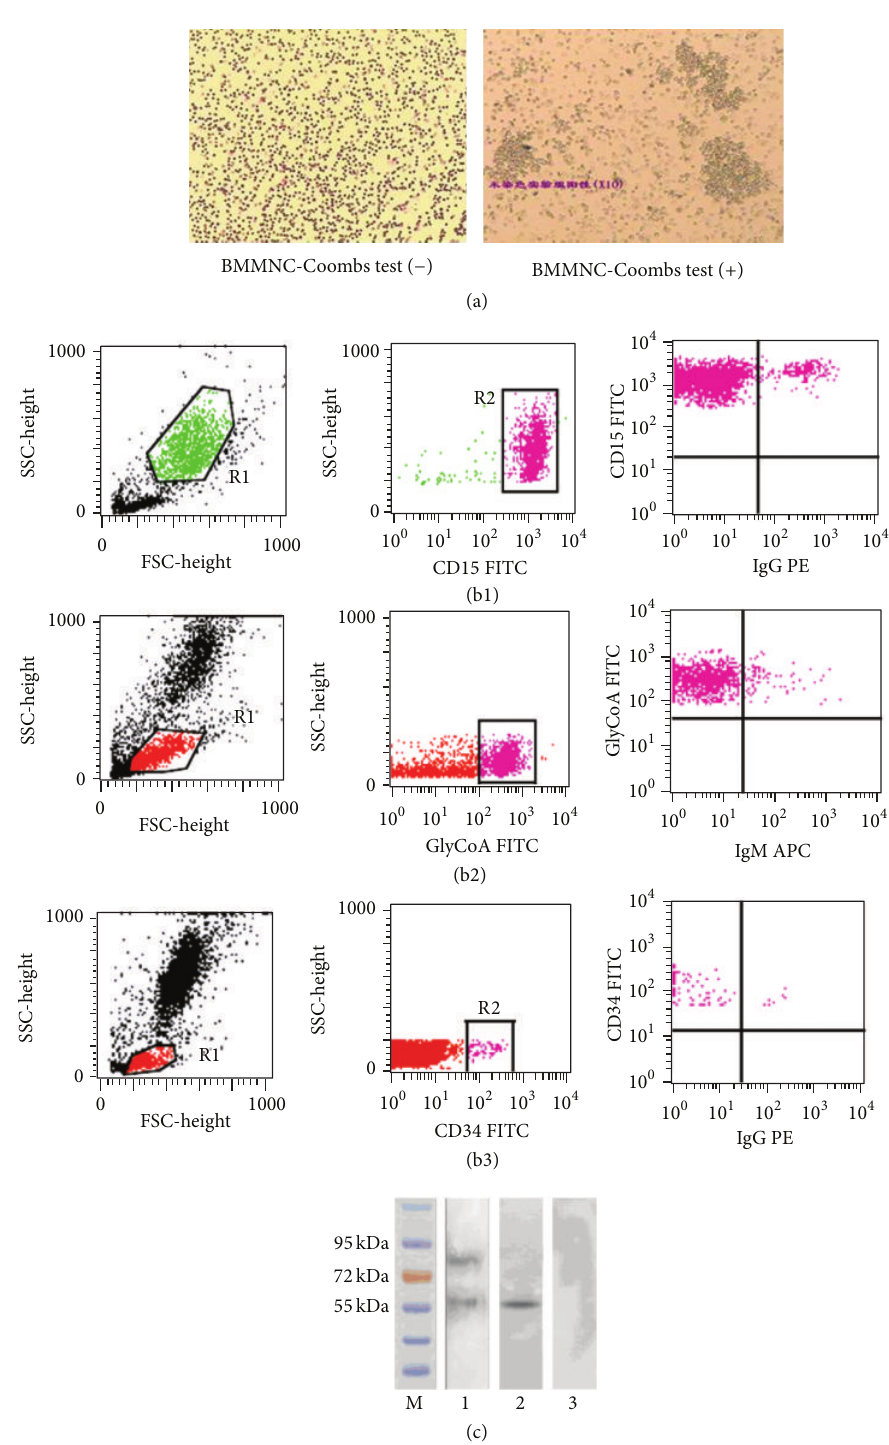
Figure 1: Autoantibodies were detected in IRP patients. (a) BMMNC-Coombs Test. (b) flow cytometry analysis: (b1) autoantibodies were detected on the granulocytes: (b2) autoantibodies were detected on the nucleated erythrocytes. (b3) autoantibodies were detected on the stem cells. (c) The BM cell membrane autoantigens targeted by IgG in IRP were identified by western blot. 1 and 2: IRP patient. 3: healthy